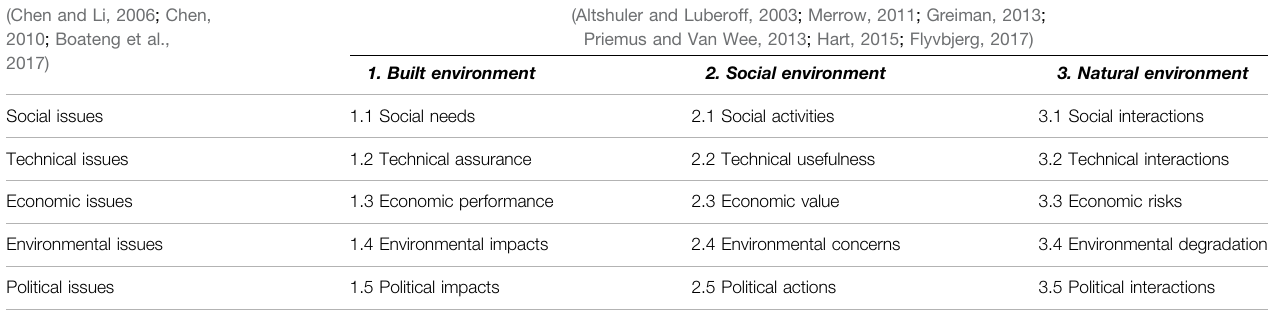
TABLE 4 | Strategic description about outcome-driven research tasks for MAS. Research outcomes Short term (ST) (Less than 5